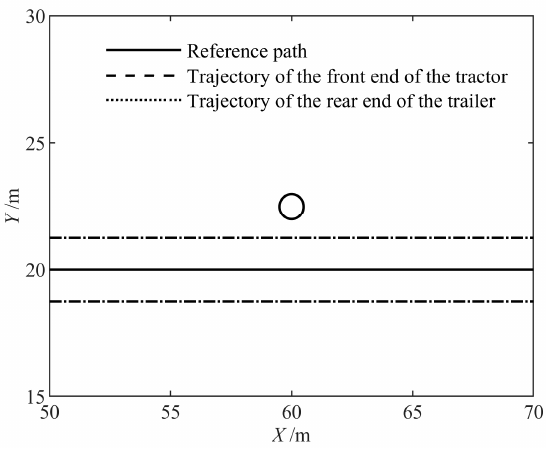
Figure 8. Partially enlarged view of Figure 7.